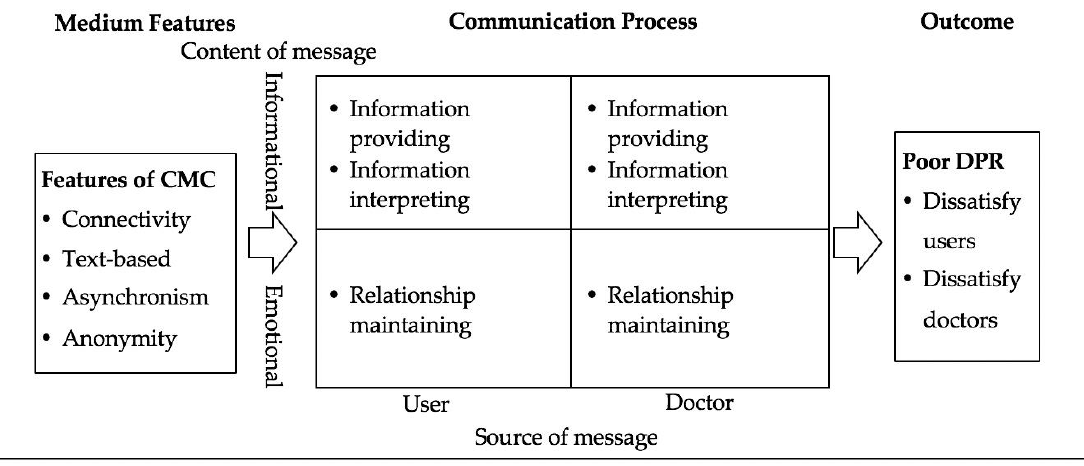
Figure 1. Theoretical framework.